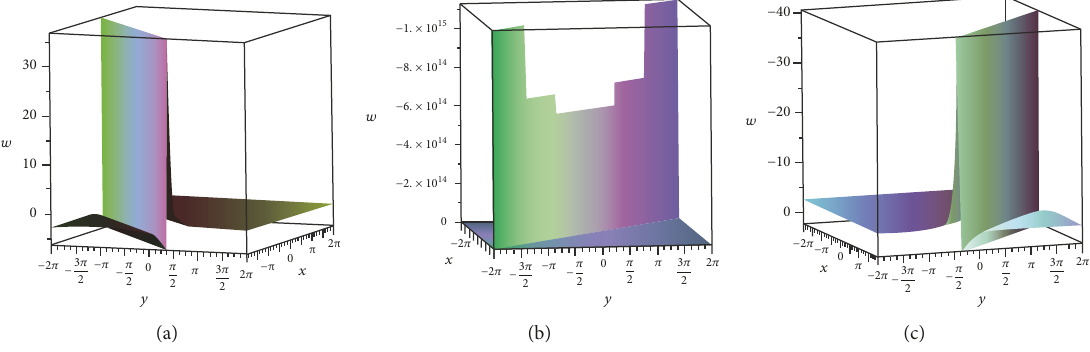
Figure 2: The solution of the (2 + 1)-dimensional Jaulent-Miodek equation corresponding to 𝑤 𝑠,2 (𝑧) , (a) 𝑡 = −5 , (b) 𝑡 = 0 , and (c) 𝑡 = 5 .